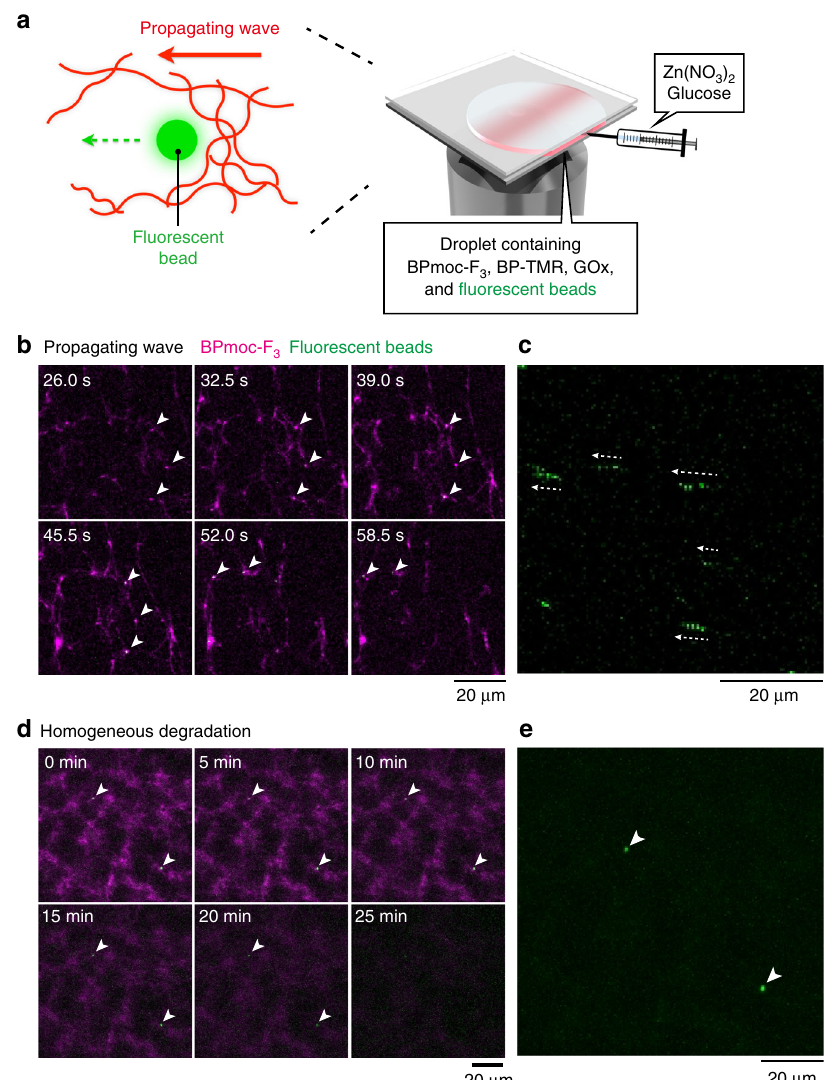
Fig. 4 Force generation by the supramolecular propagating wave. a Schematic illustration of the bead movement induced by the propagating wave. b , d Time-lapse images of the bead displacement under b the propagating wave and d homogeneous degradation of supramolecular nano fi bers. Time at b starting the time-lapse imaging or d adding glucose was de fi ned as 0. c , e Trajectories of the intensity maxima from the fl uorescently labeled beads under c the propagating wave and e homogeneous nano fi ber degradation monitored over c 26 s and e 25 min, respectively. White arrowheads show the position of fl uorescently labeled beads. Green: fl uorescently labeled beads, magenta: BPmoc-F 3 /BP-TMR. As shown in Supplementary Fig. 17, time course of fl uorescent intensity of nano fi bers showed that the propagating wave formed in Fig. 4b. Time-lapse CLSM images of the bead displacement under homogeneous nano fi ber formation were shown in Supplementary Fig. 18. Condition: [BPmoc-F 3 ] = 1.6 mM, [BP-TMR] = 0.34 µ M, [GOx] = 1.0